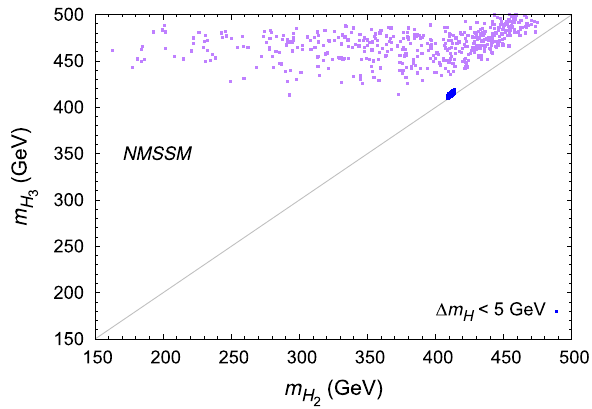
Fig. 2 The masses of H 2 and H 3 for the points obtained in the scans of the extended parameter space of the NMSSM (violet) and of its narrow region yielding (cid:11) m H < 5GeV